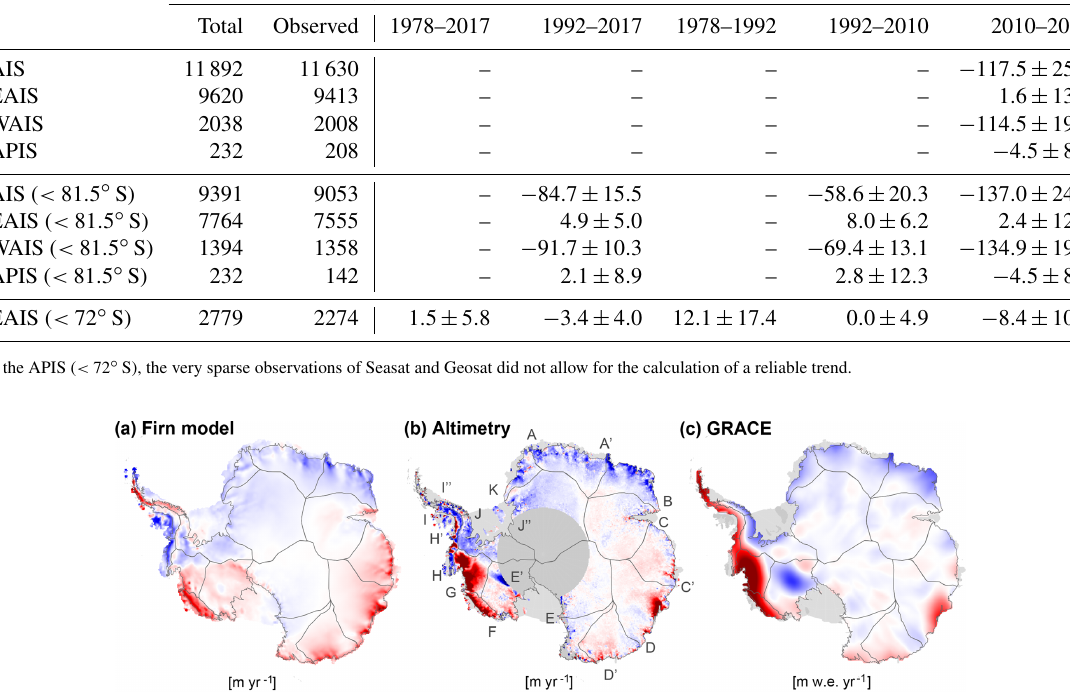
Table 2. Mass change rates for different regions of the Antarctic Ice Sheet and different time intervals. The sizes of the total and observed area refer to all cells classified as ice sheet in the respective region (and if stated are limited by the given latitude). Region